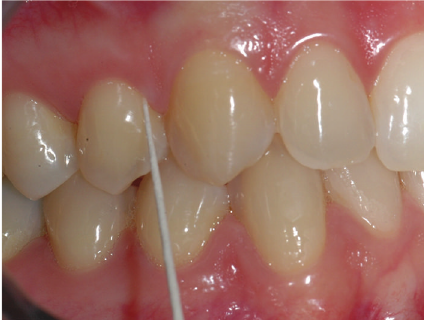
Figure 3: Example of drawings in the first upper premolar. The lips were moved with a cotton wool roll. Probing depth was collected with a paper cone from the mesial portion of the teeth.